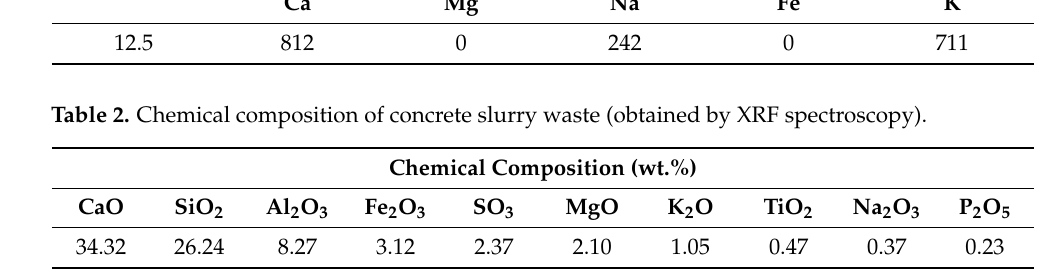
Table 1. Chemical composition of supernatant water (obtained by ICP spectroscopy).